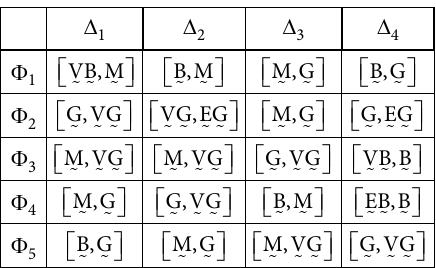
Table 7. The standardized ULT matrix from